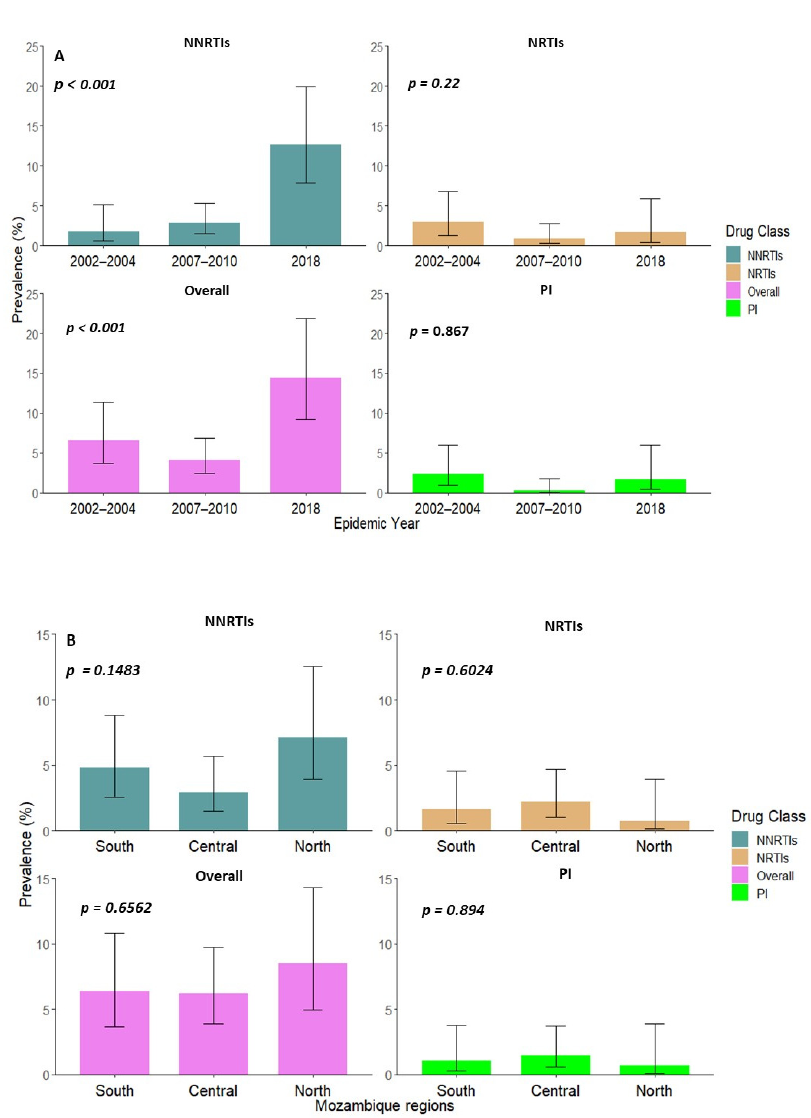
Figure 3. Temporal and regional trends for the overall, NNRTIs, NRTIs, and PIs having one or more major drug resistances over time in Mozambique. ( A ) Indicates the different temporal trends observed over the years. The x-axis represents the number of the HIV epidemic years since ARVs roll out, 2002–2004 ( n = 167), 2007–2010 ( n = 317), and 2018 ( n = 118). ( B ) Indicates the different regions of the country. The x-axis represents the three different regions of Mozambique, south ( n = 188), central ( n = 273), and north ( n = 141). The y-axis represents the prevalence rate of mutations calculated according to the Calibrated Population Resistance (CPR) analysis tool version 8.1. The p -value in each plot was established through the chi-square test over time.